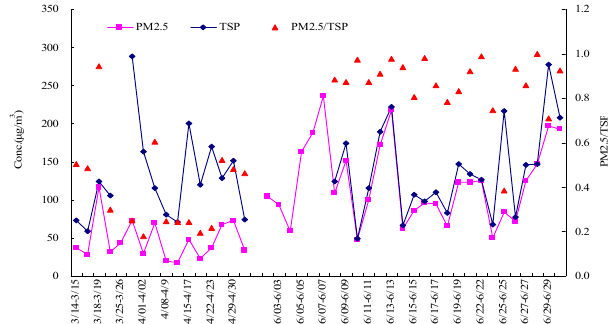
Fig. 2. Daily variations of TSP and PM 2.5 from 14 March to 30 June in 2006 at MT.